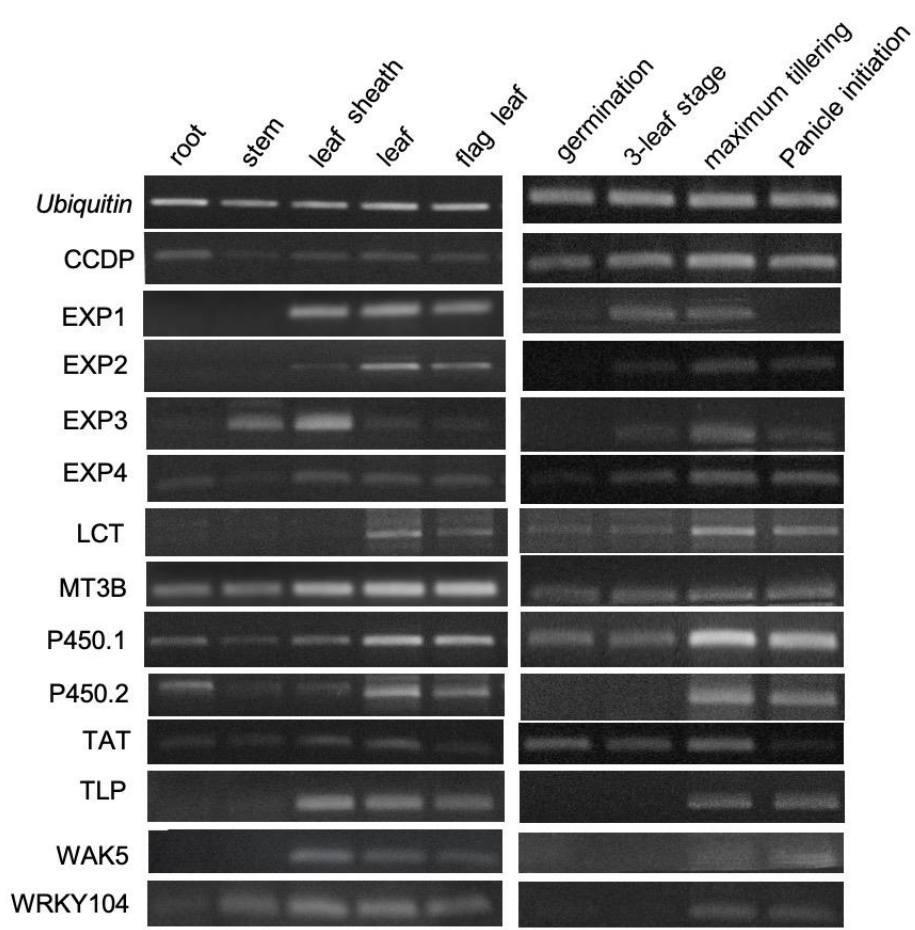
Figure 6. Expression of K2-DEGs in different tissues and growth stages of rice using RT-PCR assay. Genes were coded as follows: CCDP (AK062654), EXP1 (NM_001069356), EXP2 (LOC_Os08g26230.4),